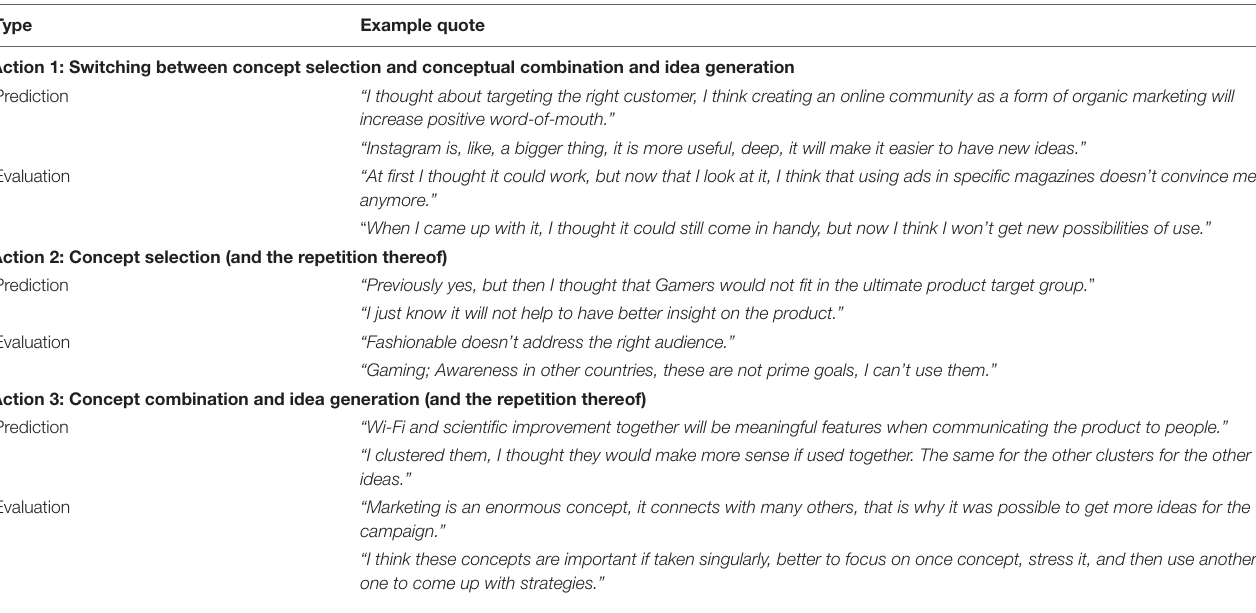
TABLE 2 | Example quotes that illustrate the type of predictions and evaluations made during the idea generation